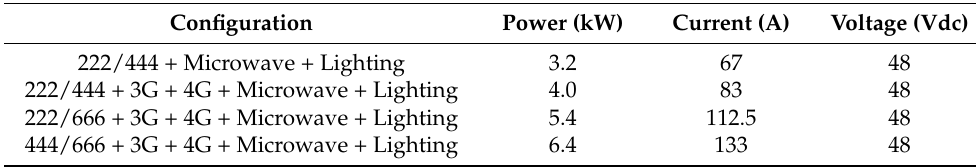
Table 1. Outdoor configuration for base stations.